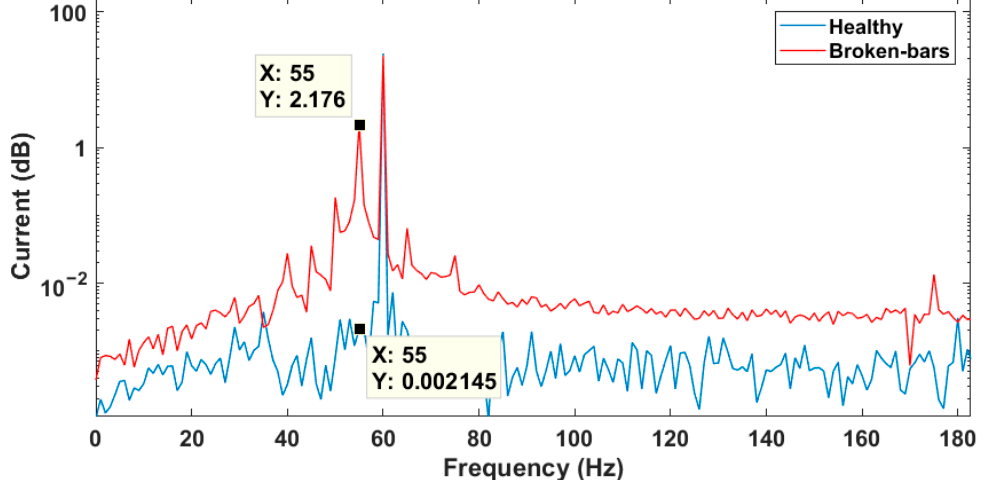
Figure 4. Frequency spectrum of healthy and faulty motor currents.